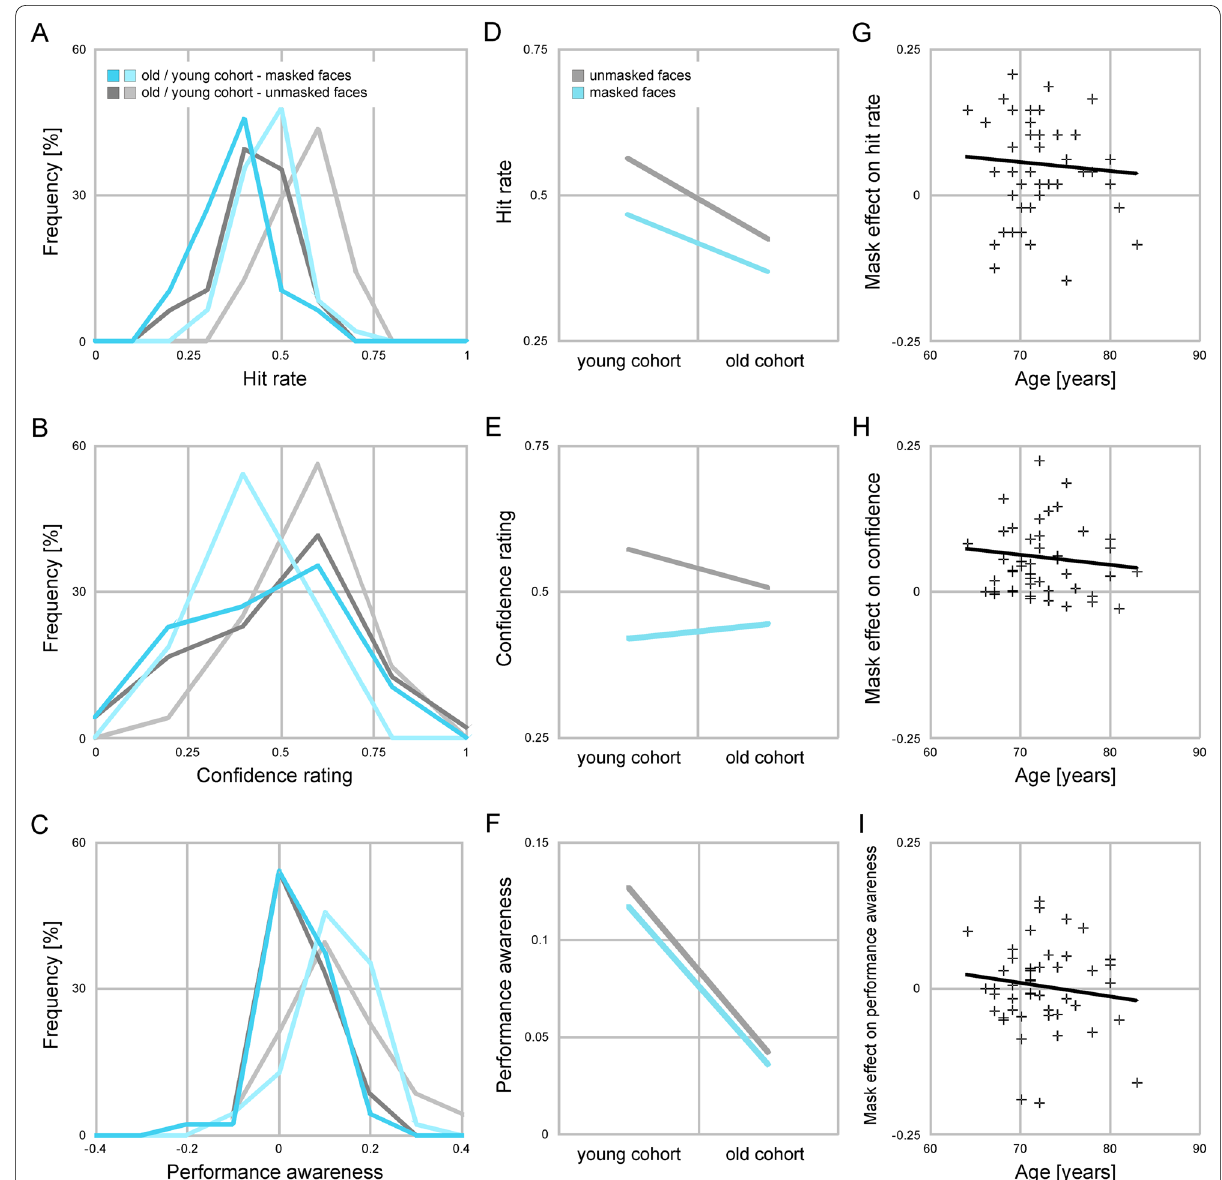
Fig. 2 Effects of face masks on facial emotion recognition. A – C , distribution of hit rates, confidence ratings and performance awareness by mask condition and age cohort. Data are binned (bin width 0.10 for hit rates and performance awareness and 0.20 for confidence ratings). D – E , mean hit rates, confidence ratings and performance awareness by mask condition and age cohort. G – I , scatter plots showing the relation between age and mask effects on hit rates, confidence ratings and performance awareness in the old cohort. Dots represent individuals, lines are regression lines. Confidence ratings are rescaled to unity (minimal possible value 0, maximal possible value